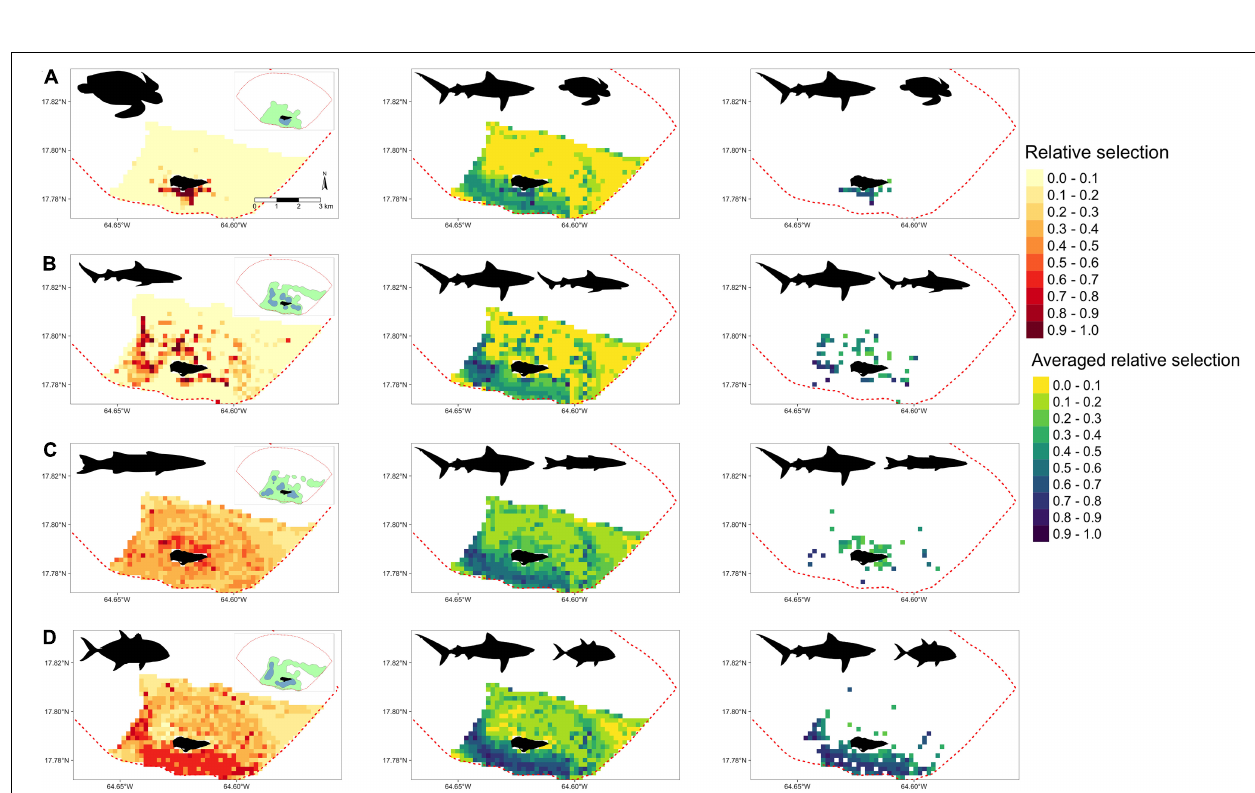
FIGURE 6 | (Left) Derived from random forest models, the predicted and extrapolated probability of relative selection across Buck Island National Reef Monument (designated by red dashed line) for (A) juvenile green turtles (B) juvenile Caribbean reef sharks, (C) great barracuda, and (D) horse-eye jacks. 50% (green) and 95% (blue) kernel density estimates shown in the upper right corner of each plot. (Middle) Relative selection values averaged between tiger sharks and each corresponding species on the left. (Right) Relative selection values averaged between tiger sharks and each corresponding species on the left after the removal of cells where potential prey relative selection values were < .5. In all plots, higher and darker values indicate higher relative selection values or their averages.